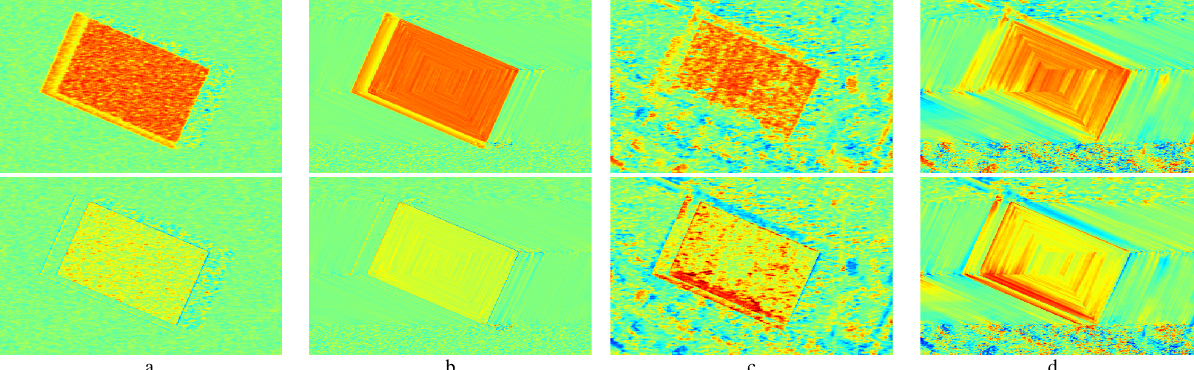
Figure 6. Filter results and differences between of noise-free simulated phases (Figure 4a) and filtered interferometric phases: a) Mean-coherence-filter and b) GIS AWF (mean+coh) on noisy simulated phases, c) Mean-coherence-filter and d) GIS AWF (mean+coh) on real interferometric phases